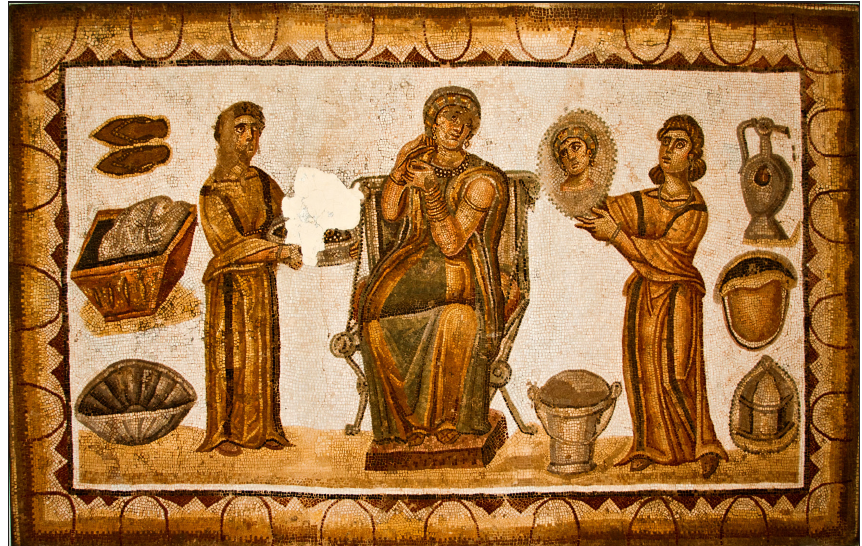
Figure 9: The Matron Mosaic at Sidi Ghrib, Musée National de Carthage. (Photo: Fabien Dany